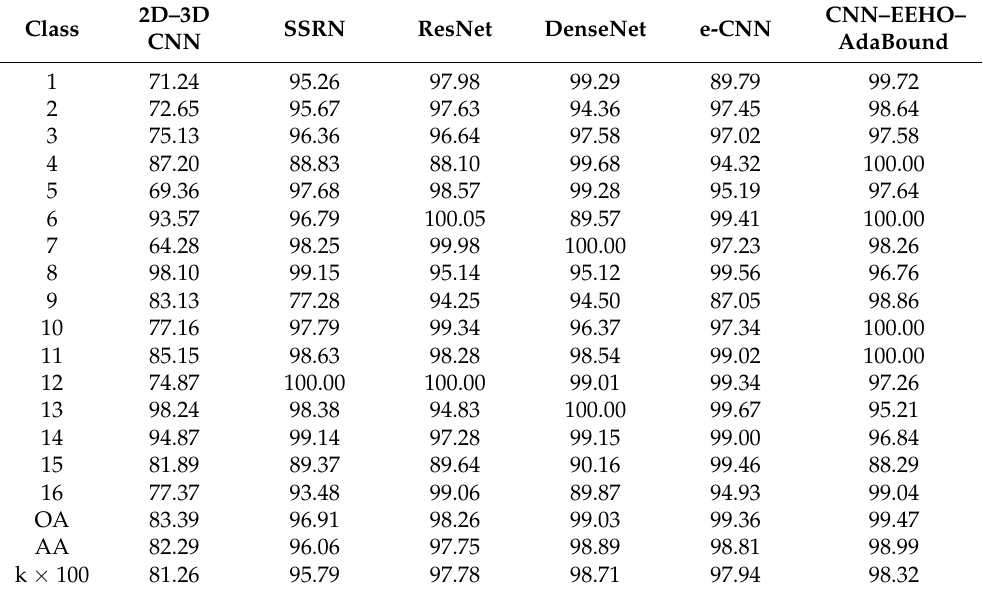
Table 4. Class-wise overall accuracy (OA%), average accuracy (AA%), and k kappa are represented in the Indian Pines